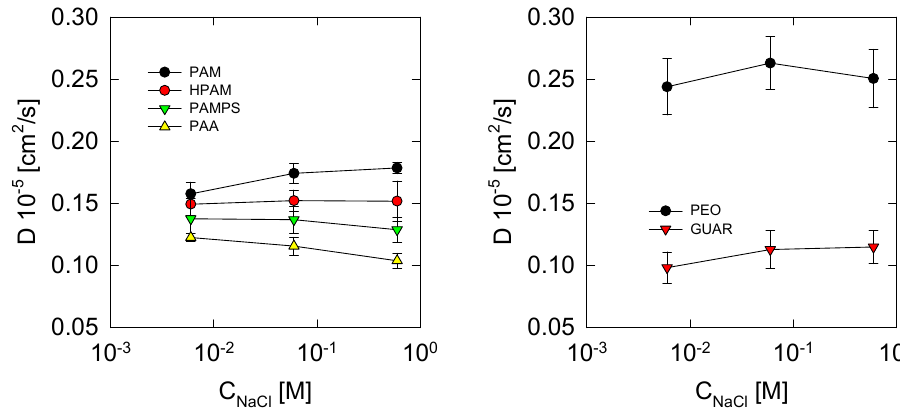
Figure 6. Diffusion coefficient of polymers at different salt concentrations at 300 K.